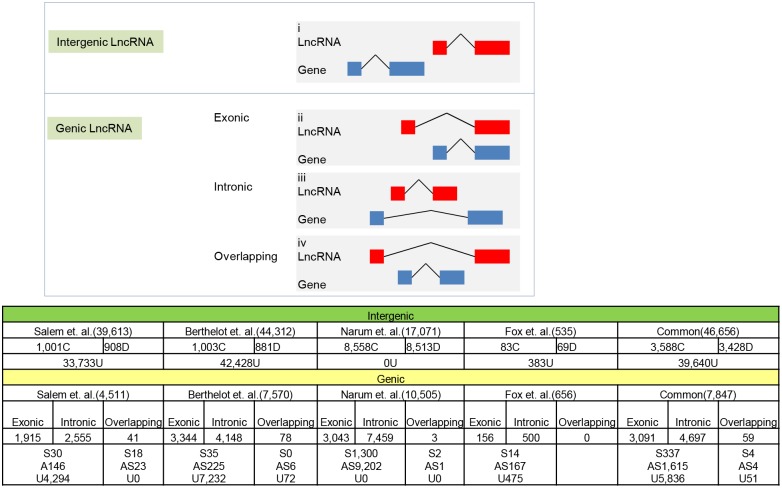
Classification of lncRNAs based on their intersection with protein-coding genes and number of lncRNAs in each class.Diagram on the top is a visual illustration of each class of lncRNAs relative to nearest protein-coding gene(s) based on genomic position and direction of transcripts. Bottom Fig in tabular format presents number of different classes of lncRNAs from each class. Numbers inside brackets following data source references indicate total number of that particular class of lncRNAs. Letters C, D, S, AS and U indicate number of convergent, divergent, sense, anti-sense and transcripts with unknown directionality, respectively.